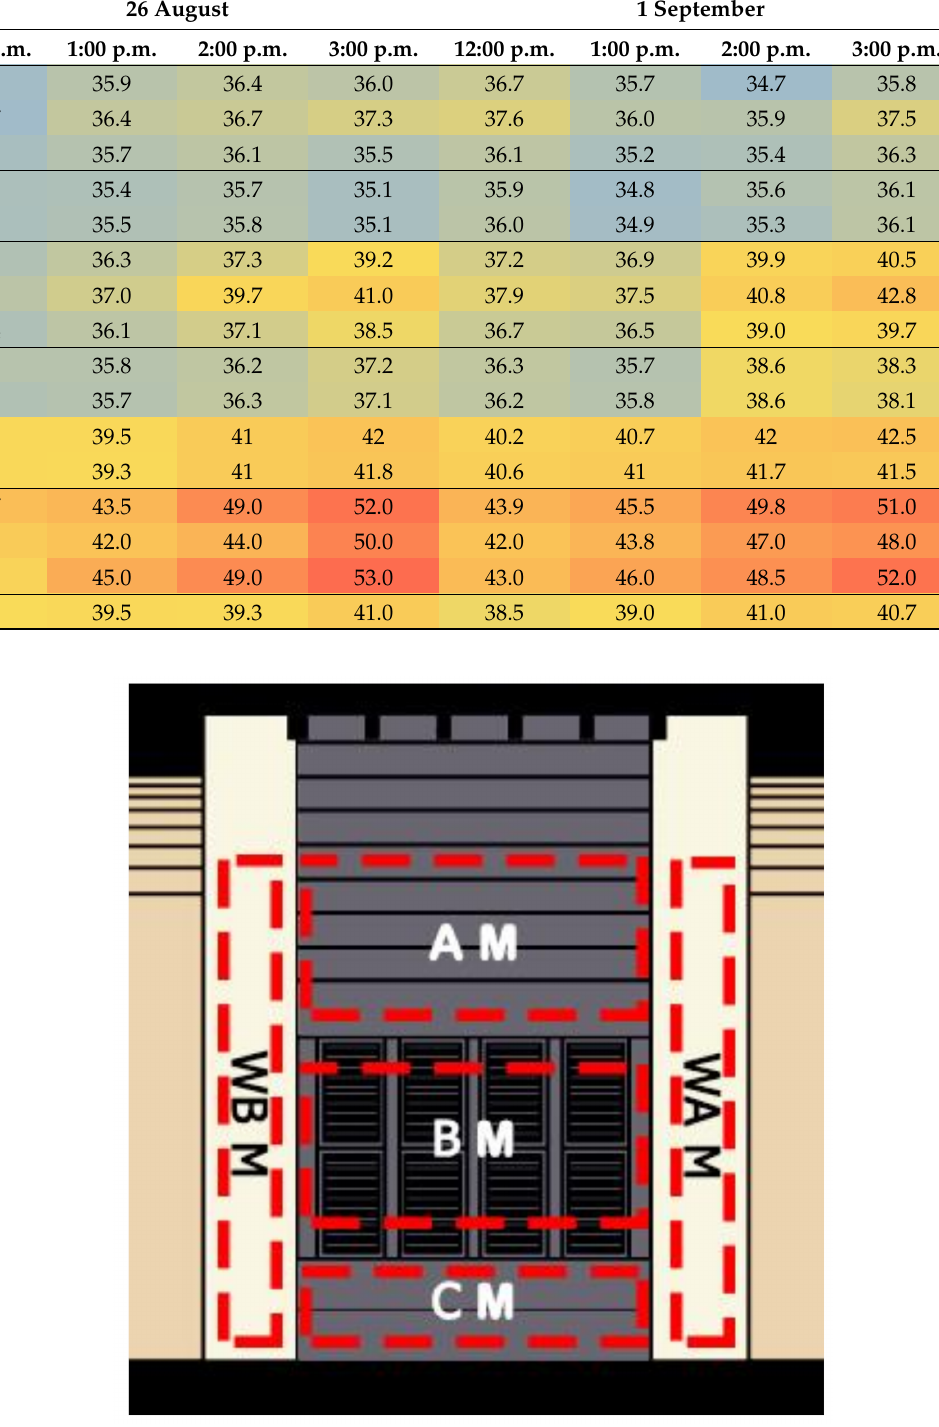
Figure 18. Interior measurement zones on the mashrabiya and abbreviated names. The measurements were monitored on 4 August at about 1:00, 2:00, 3:00 p.m. also at noon on 5, 11, 18, 26 August and 1 September while monitored at about 6:00 p.m. on 13 August 2018. As shown in tables, surface temperature measurements increased and reach the highest values, usually at 3 p.m. while the entire facade was exposed to direct Figure 20. The surface temperatures of the open mashrabiya and wall surface inside and outside.